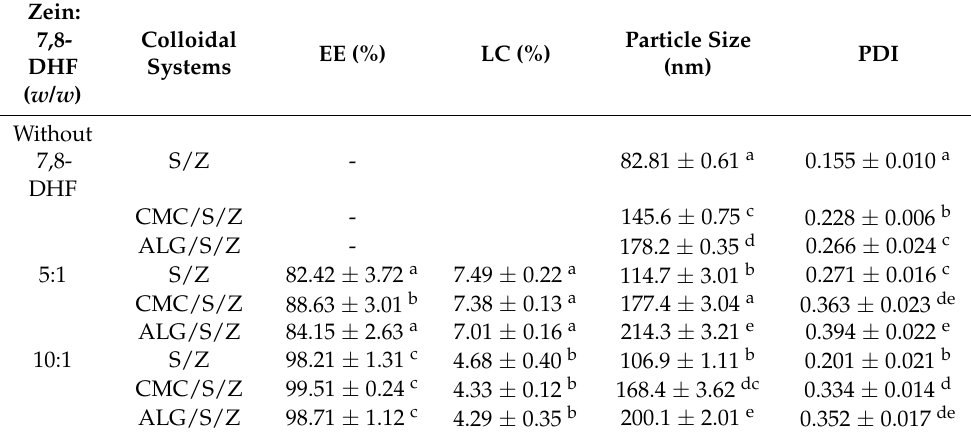
Table 1. EE, LC, particle size and PDI of 7,8-DHF in different colloidal